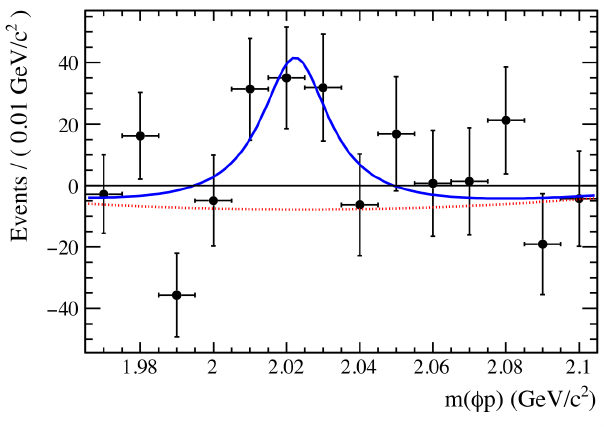
Figure 2. Invariant m ( φ p ) mass distributions in Λ c → φ p π 0 decays in the search for the P + state by Belle. For details about the background subtraction and the fit procedure see [20]. The red dotted line shows the phasespace distribution, which after background subtraction exhibits a negative fluctuation.